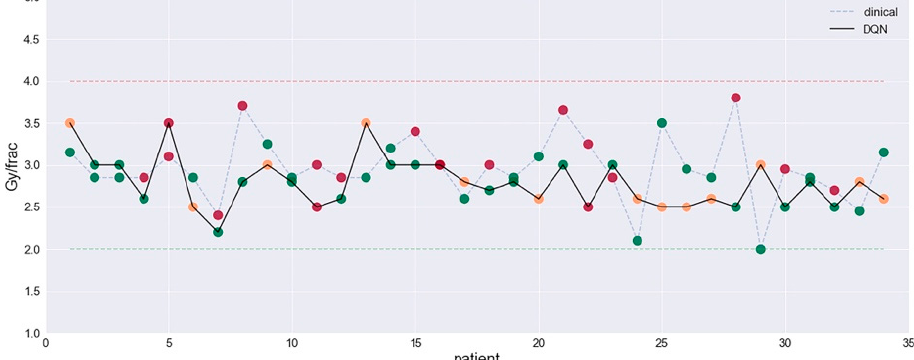
Figure 3. A response-based ART system using a three-component deep reinforcement learning (DRL). Automated dose decisions given by DQN (green dots) vs. clinical decision (blue dots) with RMSE 0.76 Gy. Dots in green and red represent indications of “good” and “bad”. Reproduced with permission from Tseng, Med Phys, 2017.